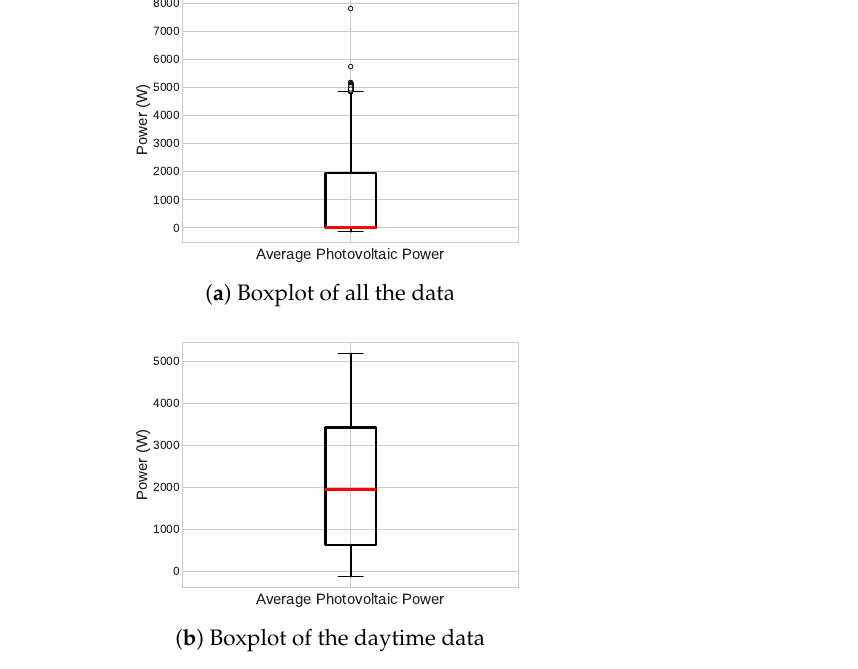
Figure 4. Boxplot of the instant power data. It is noticeable that the median is close to zero due to many samples acquired during the night. ( a ) all the data and ( b ) daytime data